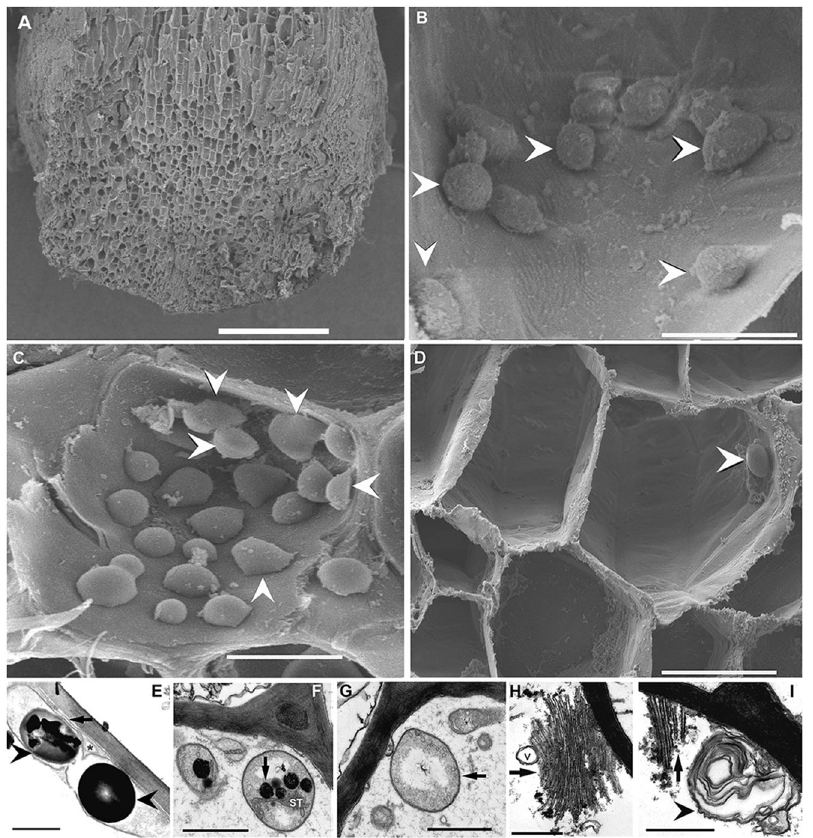
Fig. 1 Posidonia oceanica root. A – D Scanning electron microscopy (SEM). E – I Transmission electron microscopy (TEM). A , B , E , H Control (at 120h after starting the experiment). C , F Forty-eight hours after sound exposure. D , G , I One-hundred-and-twenty hours after sound exposure. A Transverse section of an apical portion of P. oceanica root showing the opened root cap containing the columella cells. B Opened columella cell showing normally shaped inner starch grains (arrowheads). C Some starch grains presented a deformed structure without the typical spherical shape (arrowheads). D The number of inner starch grains in columella cells dramatically decreased. Only one remaining starch grain is visible (arrowhead). E Amyloplasts containing prominent starch grains (arrowheads). Note the association of endoplasmic reticulum cisternae (arrow) with the amyloplasts and the presence of a vesicle (asterisk). F Absence of starch grains and presence of plastoglobuli (arrow) in amyloplasts in close association with stroma thylakoids (ST). G Note the absence of starch grains in the amyloplast (arrow). H Healthy membranous structure (Golgi complex, arrow) in columella cells (v: vesicle). I Myelin-like formation (arrowhead), provoked by sound exposure. The arrow shows the leftover of a membranous structure. Scale bar: A = 0.5mm. D = 30 μ m. B , C = 10 µ m. E – I = 1 µ